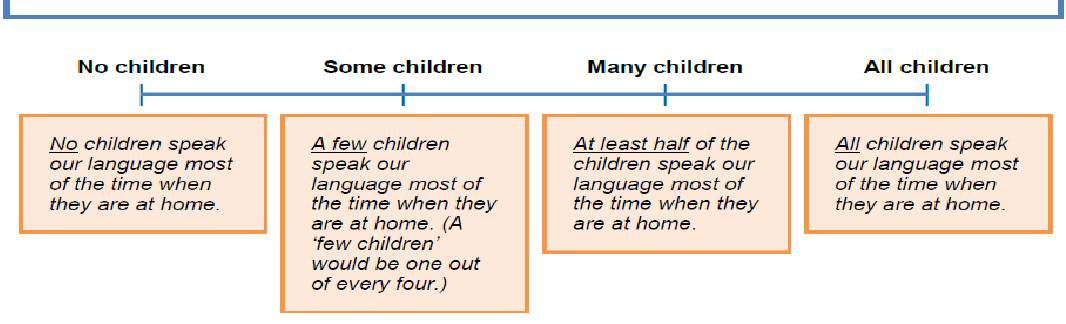
Figure 1. Example of a diagnostic statement from Guide for Planning the Future of Our Language, p33